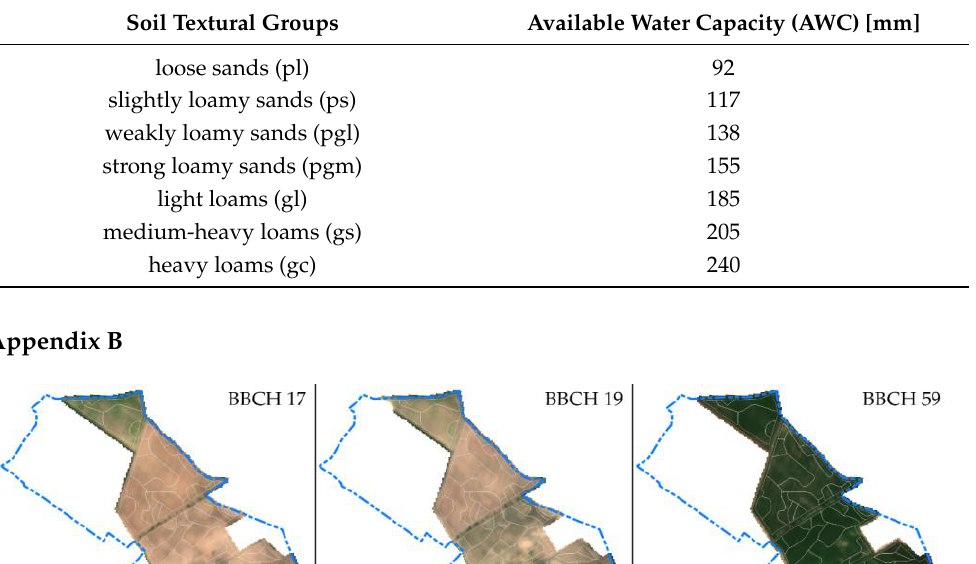
Table A2. Parameters of available water capacity for plants in various granulometric soil grain [42].